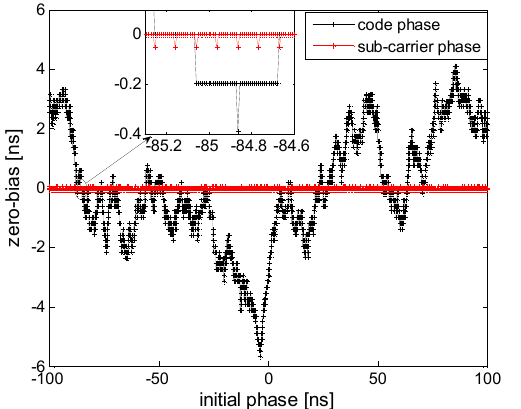
Figure 3. The zero-bias of BOCs (1, 1) signal under different initial phase.